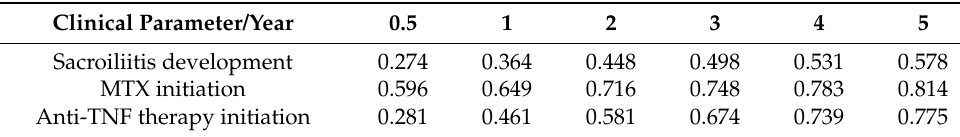
Table 3. Cumulative probabilities of sacroiliitis development, initiation of MTX or anti-TNF therapy ( n = 146).